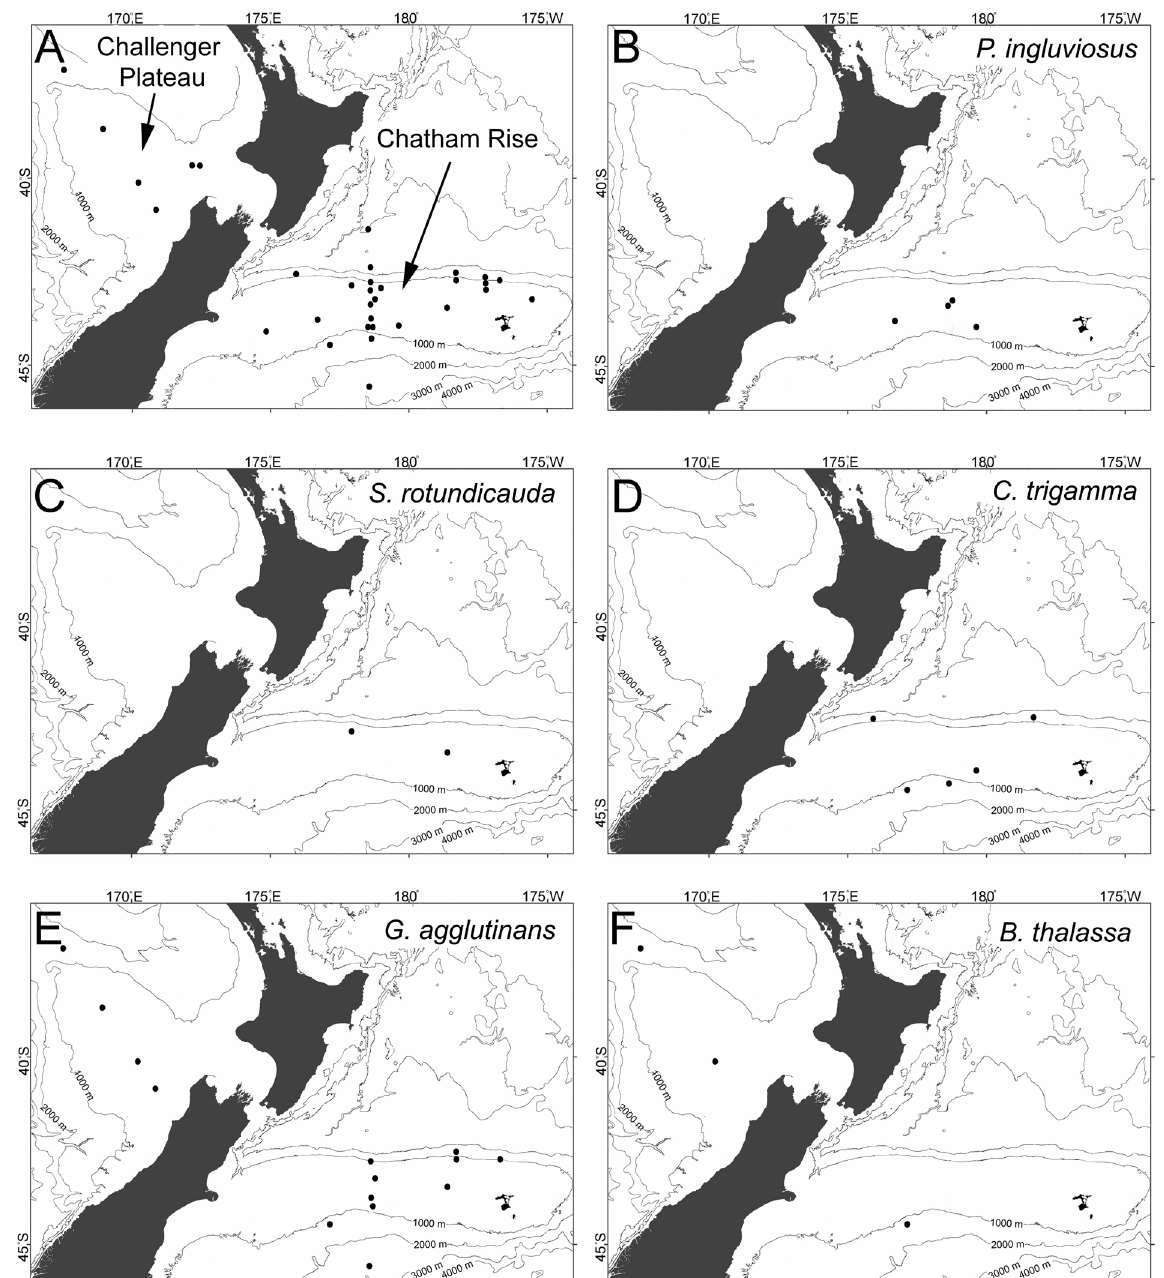
Fig. 17. Map of the New Zealand region with 1000 m water depth contours. A . Location of the sites sampled on Chatham Rise and Challenger Plateau. – B-F. Distributions of individual species. – B . Pseudocheironchus ingluviosus gen. et sp. nov. C . Synonchiella rotundicauda sp. nov. D . Cobbionema trigamma sp. nov. E . Gammanema agglutinans sp. nov. F . Bendiella thalassa gen. et sp.